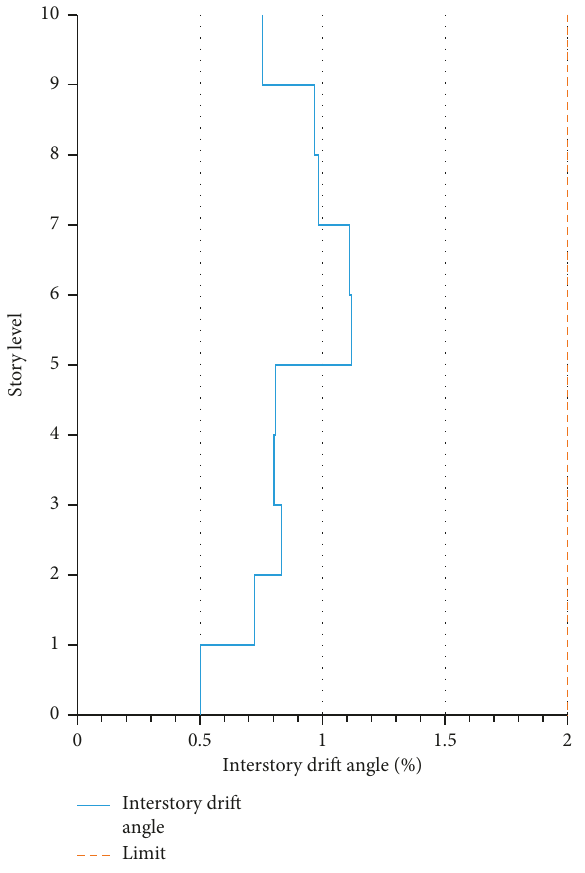
Figure 12: The average values of the interstory drift angle under different